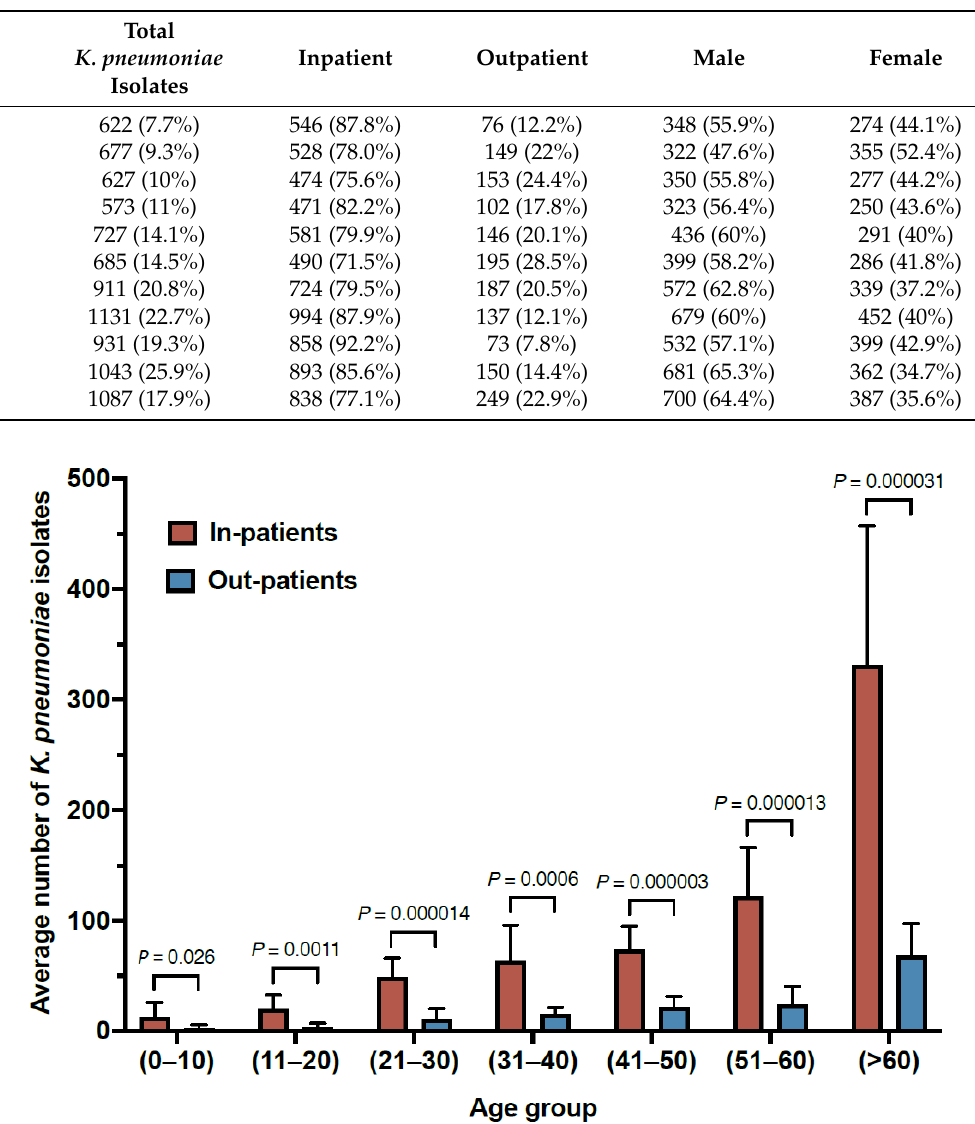
(Figure 3). For example, 83.65% of K. pneumoniae isolated from blood samples were obtained from inpatient specimens, and the remaining 16.35% were from outpatients (Figure